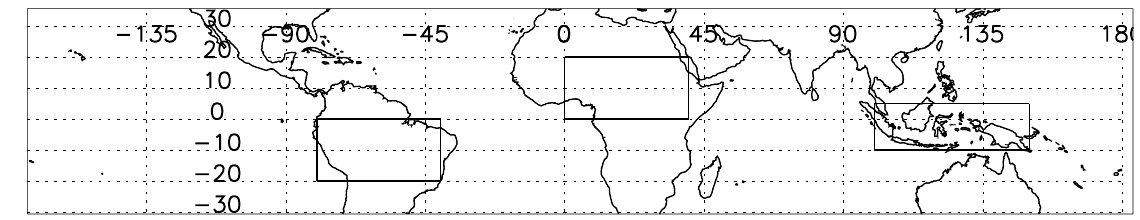
Fig. 1. The rectangles show the regions which were examined in this study, South America, West Africa and the Maritime